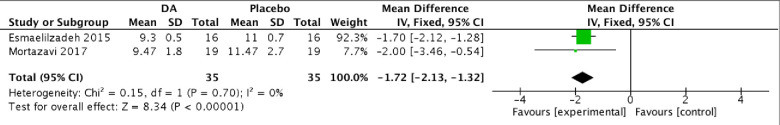
Forest plot of comparison.Aspirin desensitization vs placebo, outcome: Medication score.